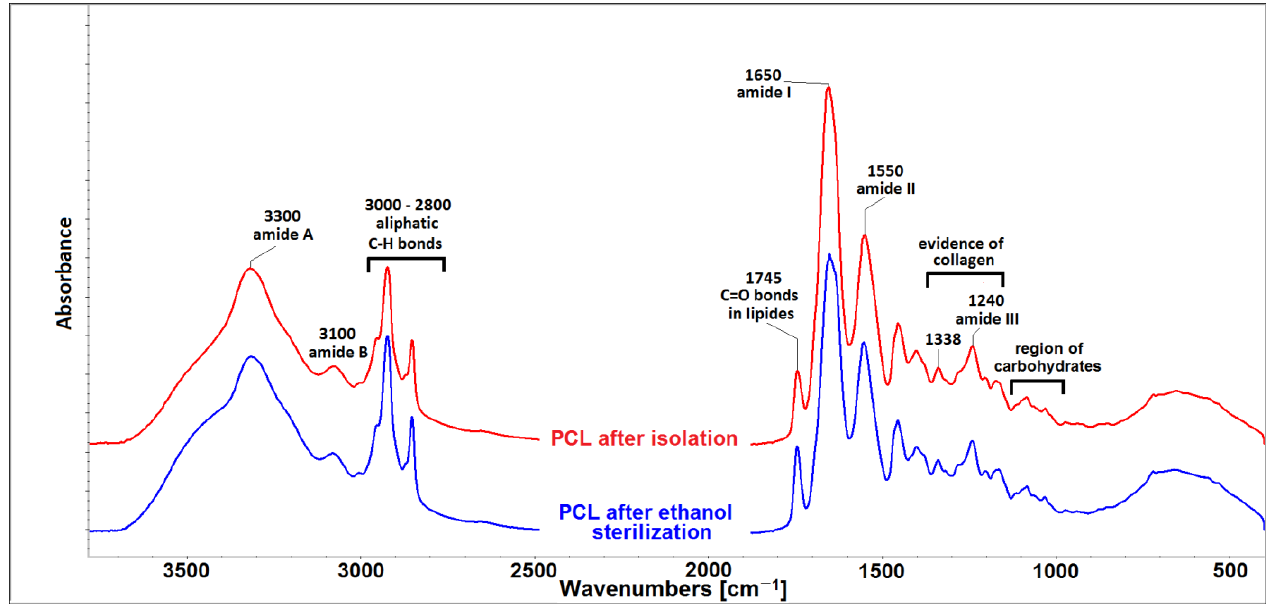
Figure 2. FTIR spectrum of porcine collagen lyophilisate (PCL) after isolation and after ethanol sterilization.